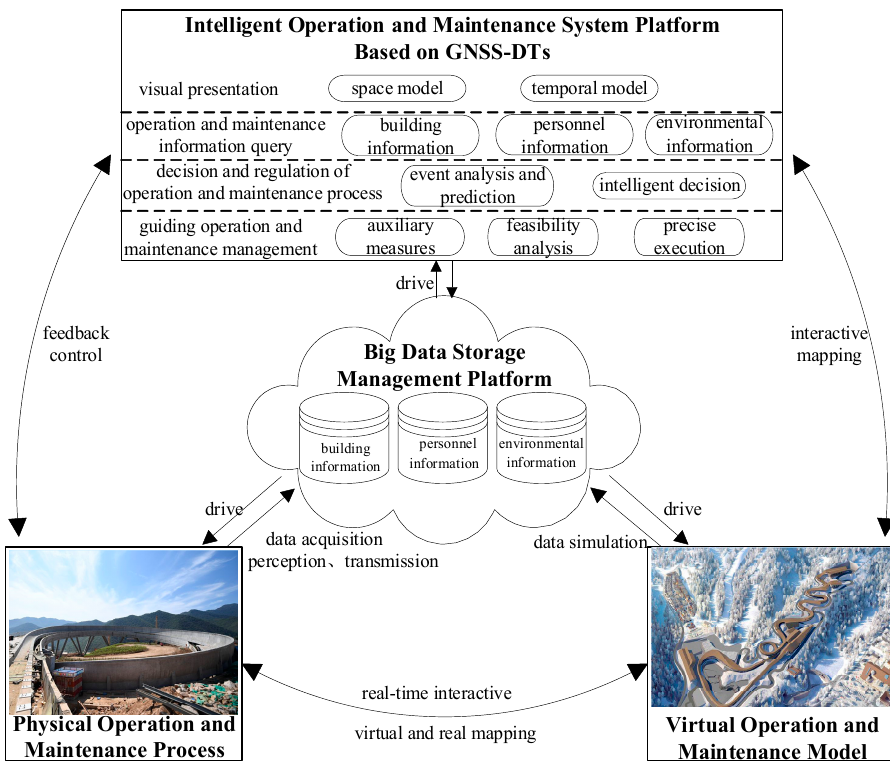
Figure 4. Intelligent O&M architecture based on GNSS–DTs.